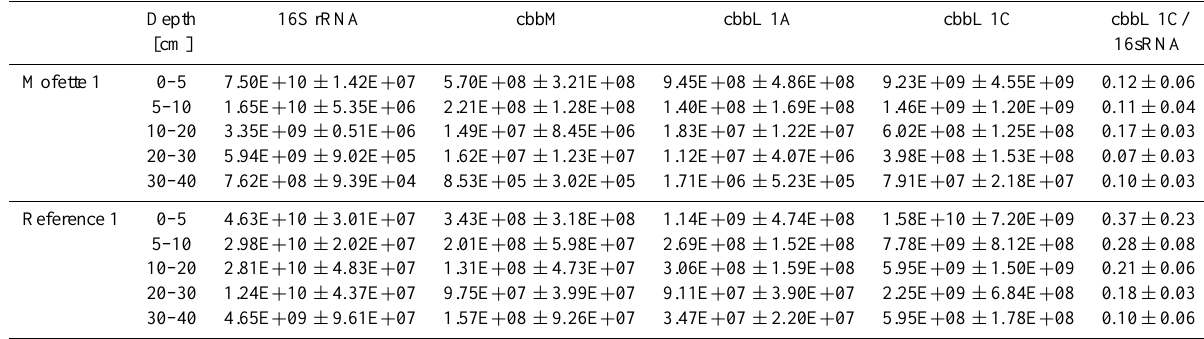
Table 3. Quantification of 16S RNA, cbbL, and cbbM marker genes. Uncertainties represent ± 1 σ standard deviation ( n =